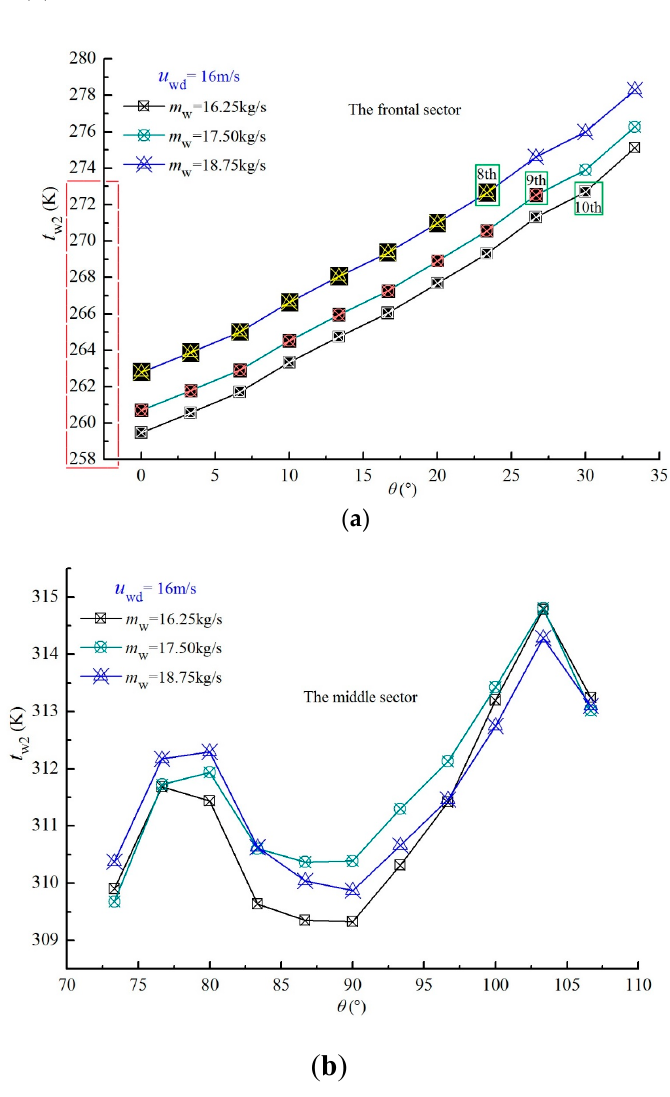
Figure 13. Outlet water temperature of each delta in frontal and lateral sectors under crosswind of 16 m/s for three cases of water flow increase. ( a ) Frontal sector; ( b ) lateral sector.